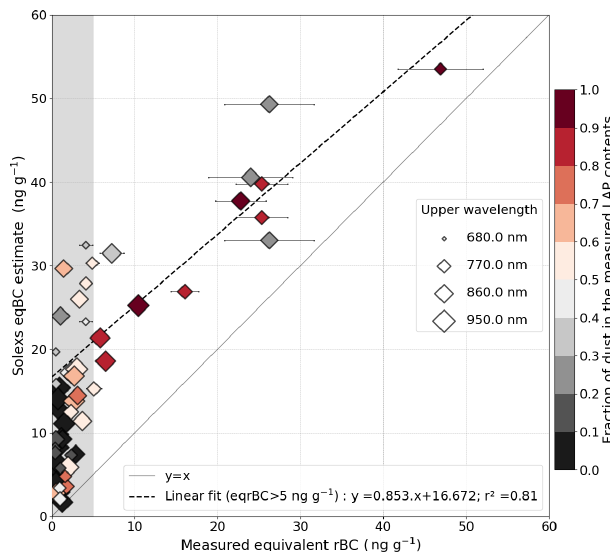
Figure 8. Comparison between measured and estimated eqBC con- centrations for all the ZOIs with concomitant LAP measurements. The grey shading corresponds to the zone below the sensitivity limit of our method (i.e. 5ngg − 1 ). The linear fit in the dotted black line is computed for points where eqrBC measured concentration is higher than 5ngg − 1 . The colour of the symbols corresponds to the propor- tion of LAP absorption coming from dust, and their size is related to the upper wavelength of the AFEC